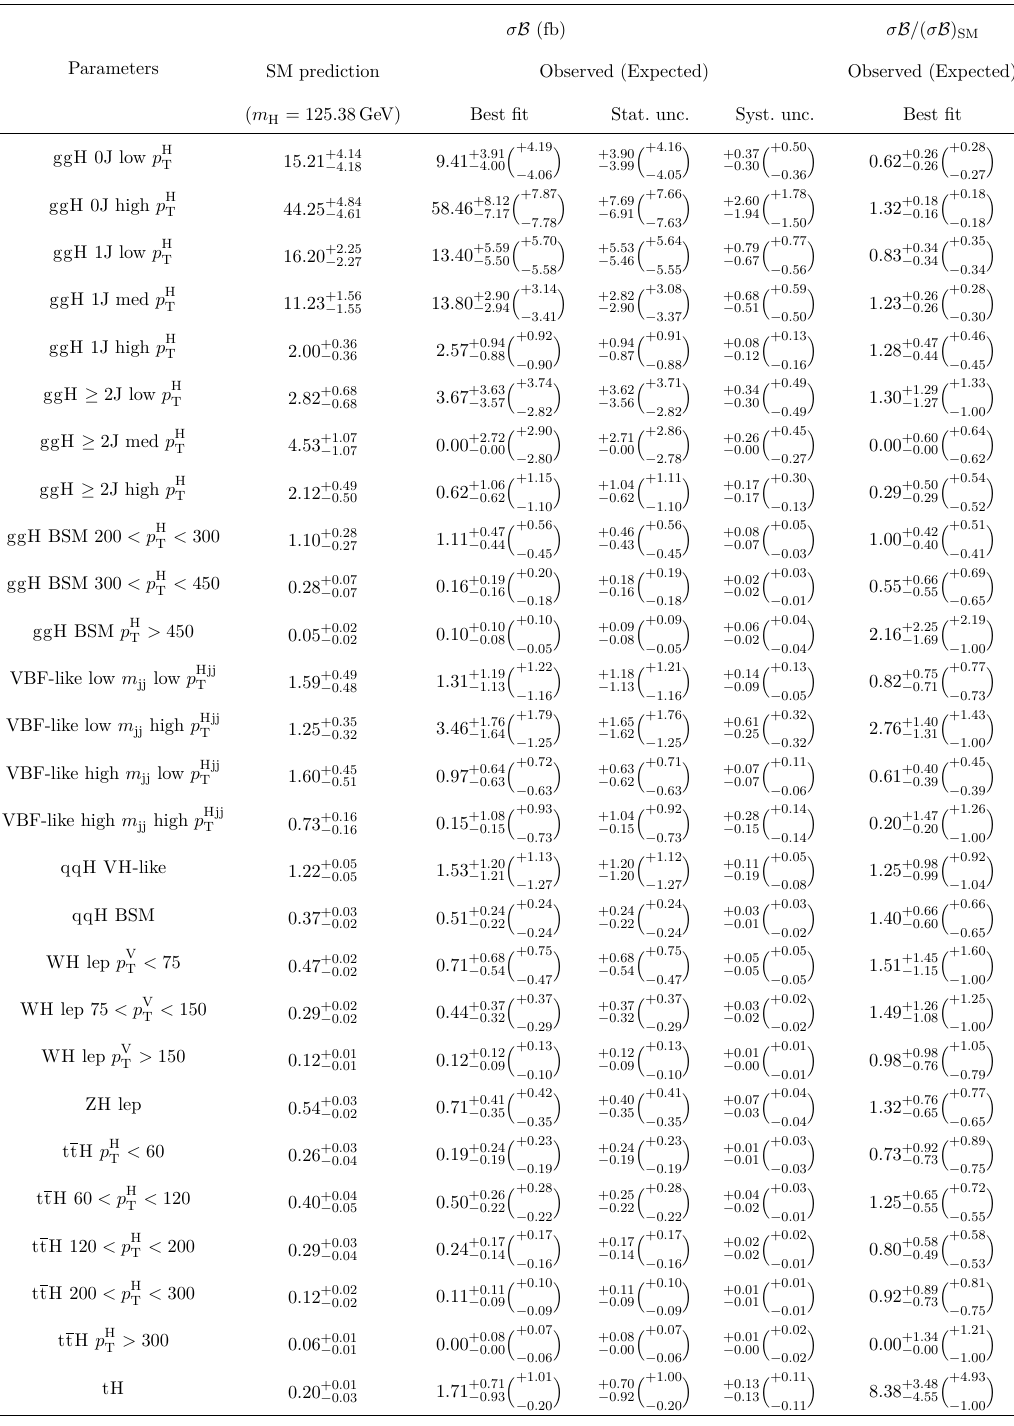
Table 13 . Results of the minimal merging scheme STXS fit. The best fit cross sections are shown together with the respective 68% CL intervals. The uncertainty is decomposed into the systematic and statistical components. The expected uncertainties on the fitted parameters, computed assum- ing the SM predicted cross section values, are given in brackets. Also listed are the SM predictions for the cross sections and the theoretical uncertainty in those